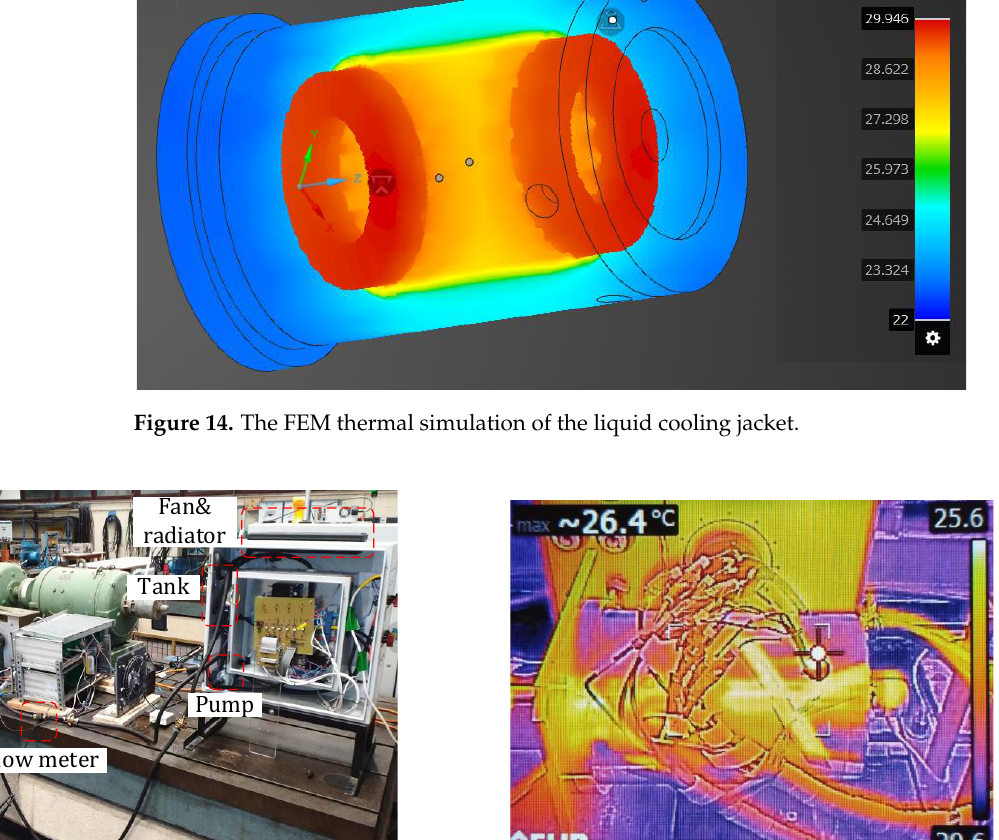
Radiator Tank Figure 12. SRM cooling setup schematic. ( a ) ( b ) Figure 13. Cooling jacket and the FEM analysis: ( a ) the CAD model of the cooling jacket and SRM; ( b ) the mesh distribution for the FEM simulation. Figure 14 shows the FEM simulation results of the cooling system for the proposed SRM. It illustrates that the highest temperature areas are at the two end-windings zones. Figure 15a presents the setup of the cooling system. Figure 15b illustrates the meas-